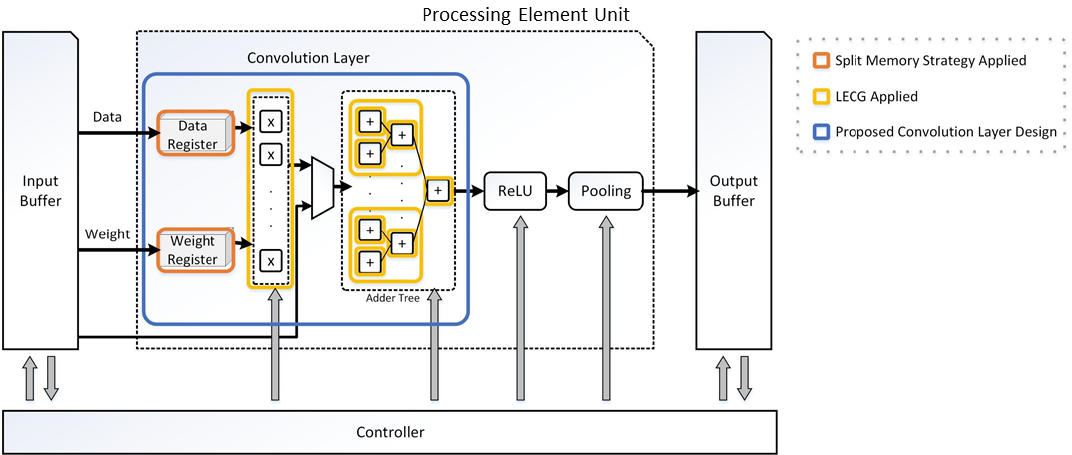
Figure 7. Proposed CNN accelerator architecture.